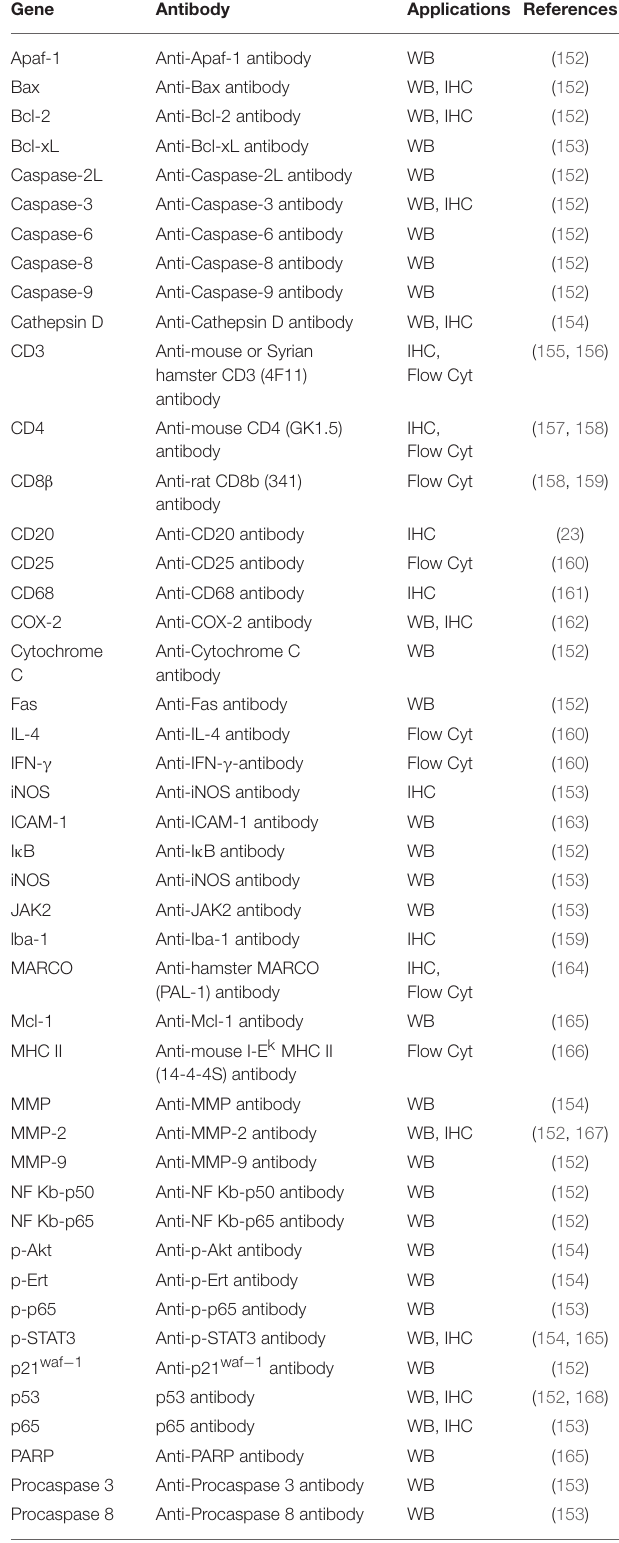
TABLE 3 | List of antibodies tested in Syrian